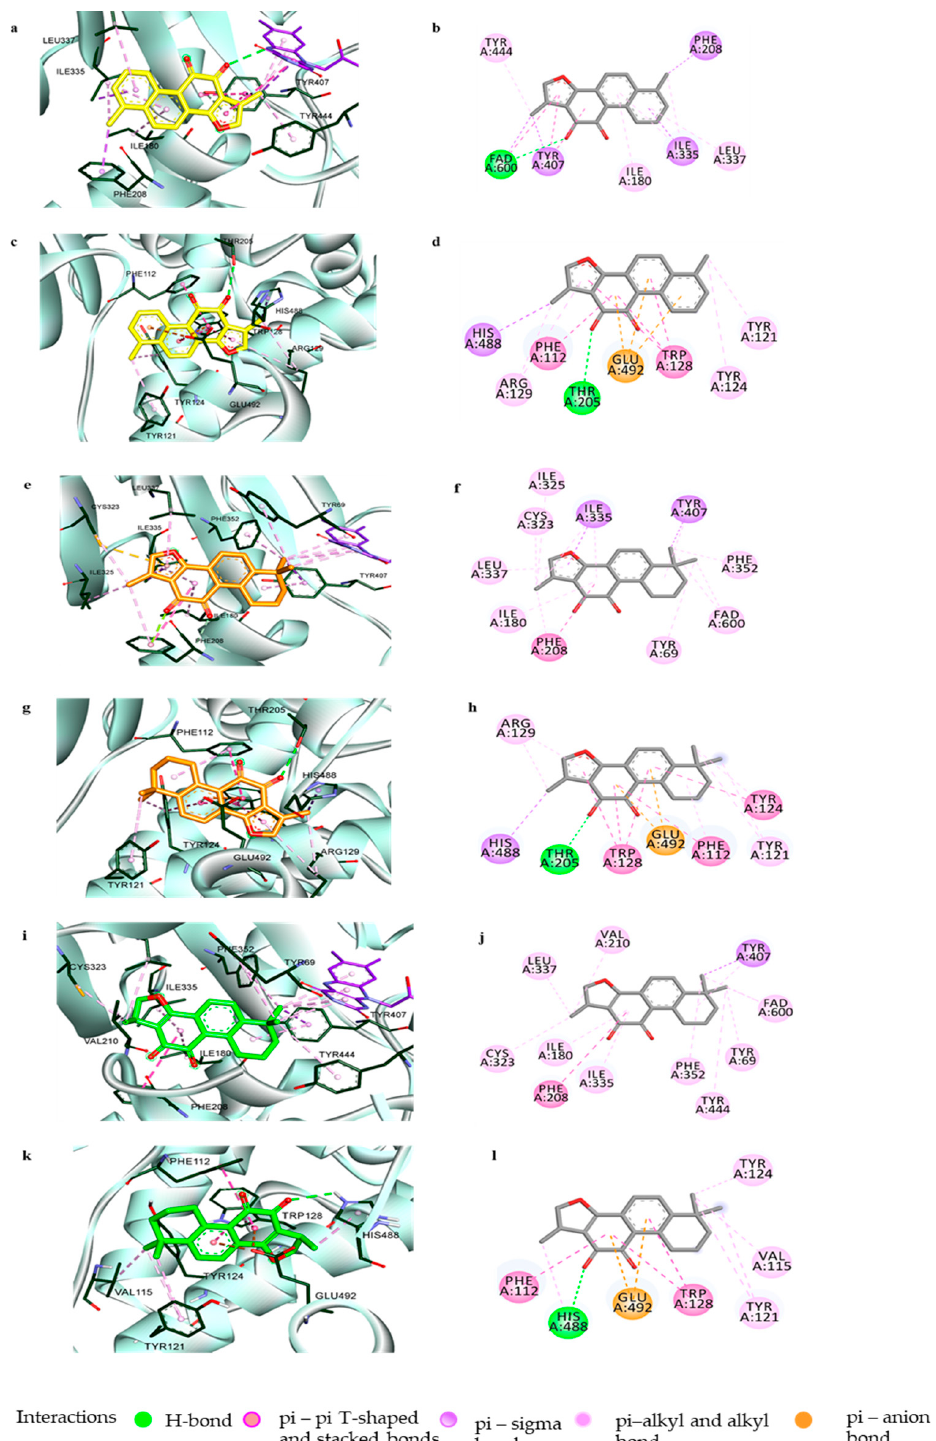
Figure 4. Prediction of the binding modes of the tanshinones with hMAO-A by molecular docking. Close-up view of tanshinone I (yellow), tanshinone IIA (brown), and cryptotanshinone (green) at the catalytic ( a , e , i ) and allosteric ( c , g , k ) binding sites of hMAO-A, respectively. 2D-binding diagrams showing the ligand–enzyme interactions for tanshinone I, tanshinone IIA, and cryptotanshinone at the catalytic ( b , f , j ) and allosteric ( d , h , l ) sites of hMAO-A, respectively.